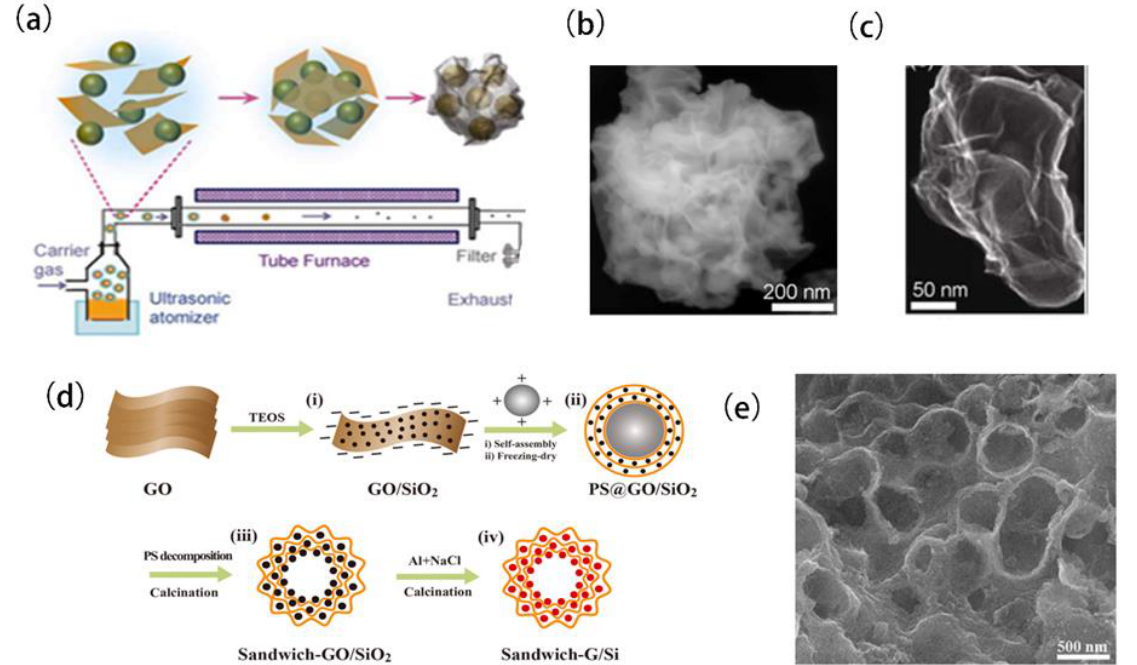
Figure 8. ( a ) Schematic illustration of the preparation process and ( b ) SEM and ( c ) TEM image of Si@G anode material by one-step capillary-driven assembly route in aerosol droplets [53]. ( d ) Schematic illustration of the preparation process and ( e ) SEM image of GR/Si hollow spherical anode material [58]. Reprinted with permission from [53]. Copyright 2012 American Chemical Society. Reprinted with permission from [58]. Copyright 2021 Elsevier.